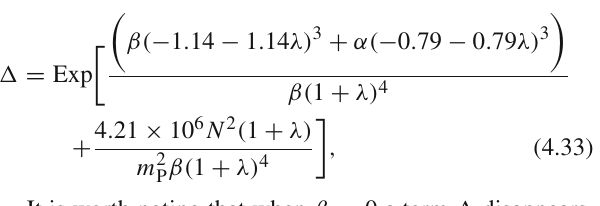
must be negative in a range − 1 . 0 (cid:13) β < − 0 . 1 together with α (cid:13) 0 .